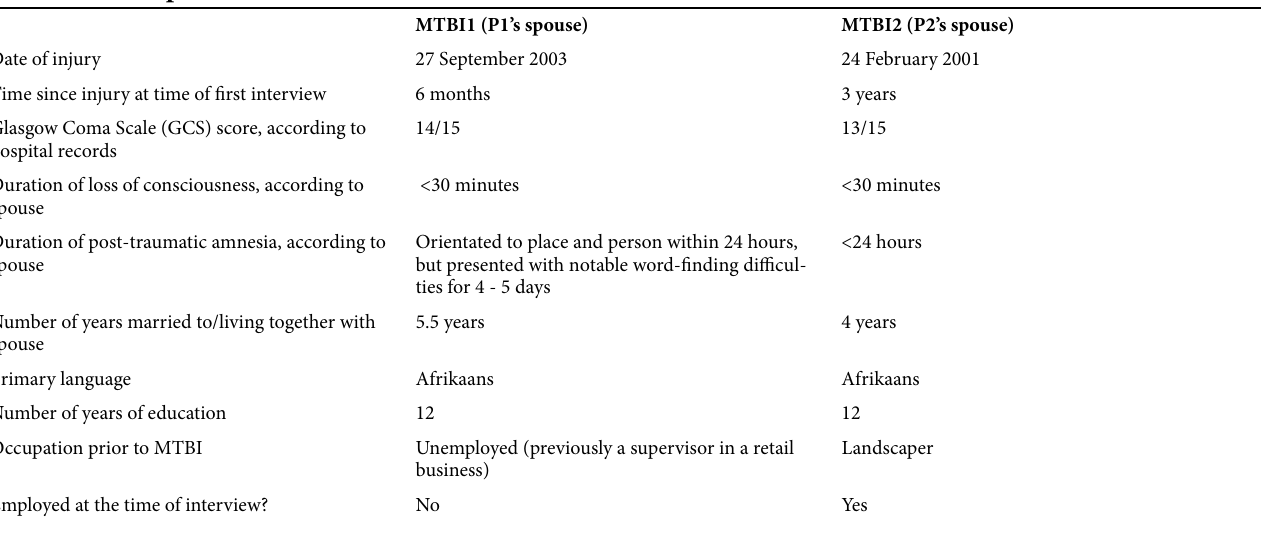
Table II. Description of individuals with